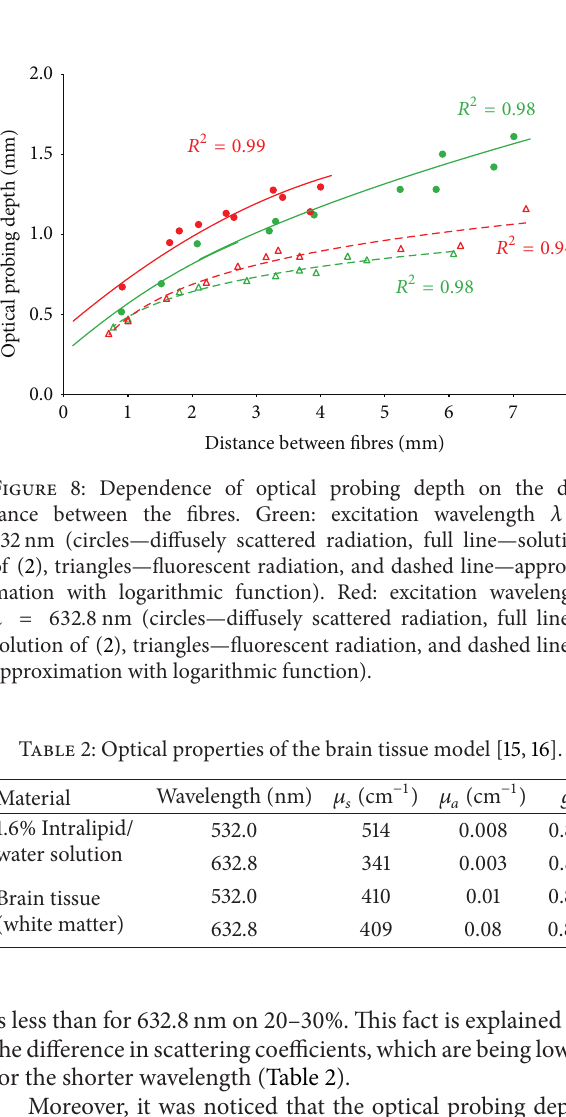
Figure 6: The most probable photon paths distribution between two sources for (a) 532 nm and (b) 632.8 nm (distance between the fibres, 1.7 mm). 1—Experiment, 2—MC simulations, 3—diffuse approximation, and 4—intersection of 1 and 2.